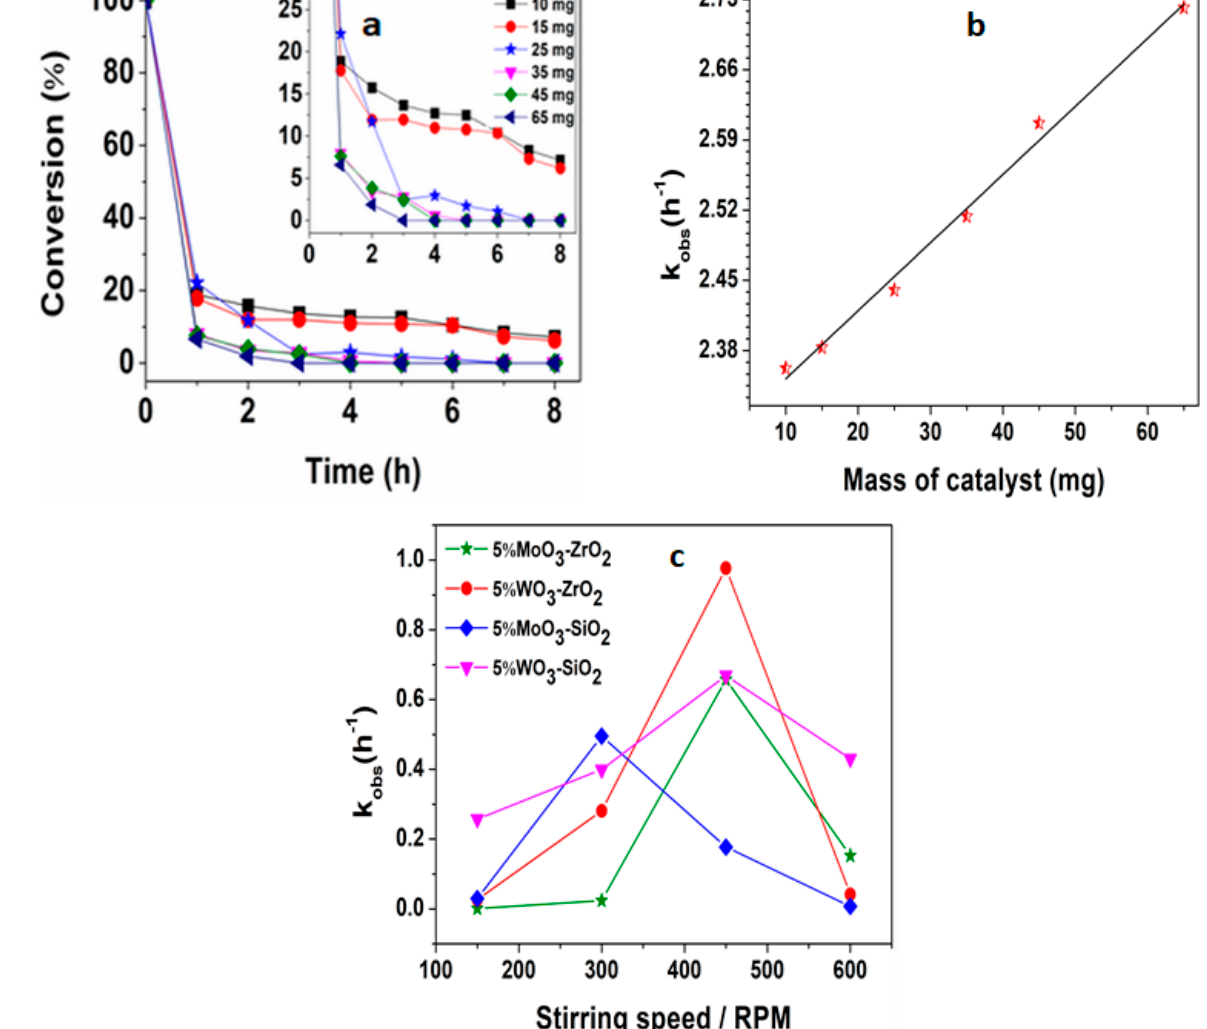
Figure 2. ( a ) Variation of catalyst concentration (5%MoO 3 -ZrO 2 ), ( b ) initial rate as a function of the catalyst mass (5%MoO 3 - ZrO 2 ), and ( c ) the influence of stirring speed vs. initial rate on ring opening of cyclohexene oxide utilizing distinct catalysts.